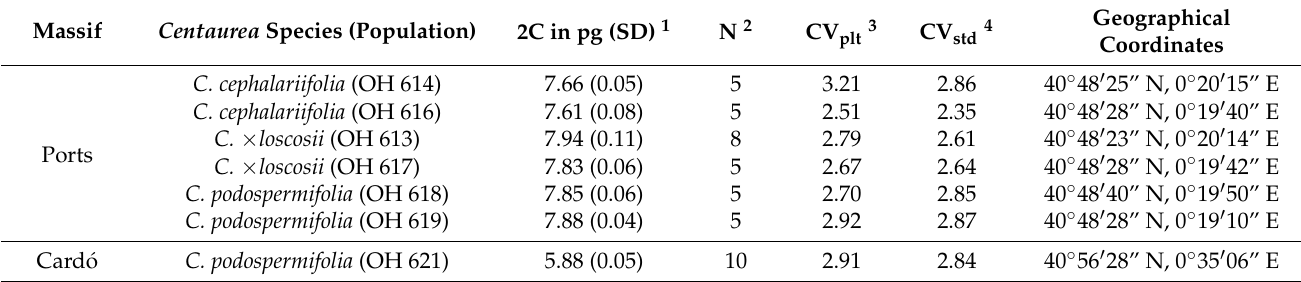
Table 1. Genome size data for populations of Centaurea cephalariifolia , C. × loscosii and C. podospermifolia at Cardó and Ports Massifs (Catalonia, Spain), with indication of geographical coordinates. Massif Centaurea species (Population) 2C in pg (SD) 1